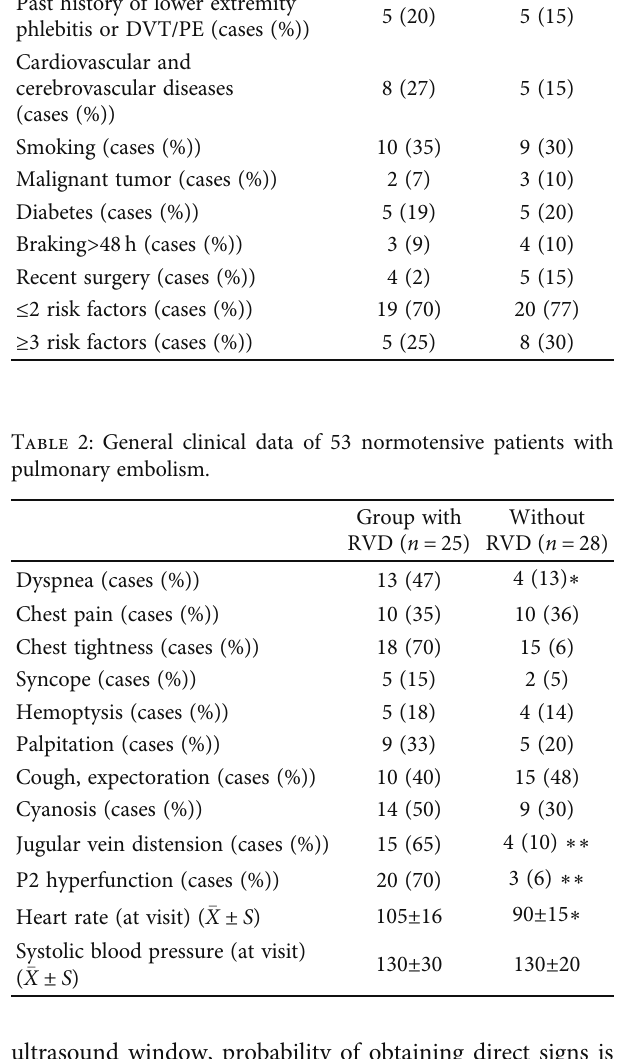
Figure 3): 7 (28%) of 25 patients with RVD had PE-related